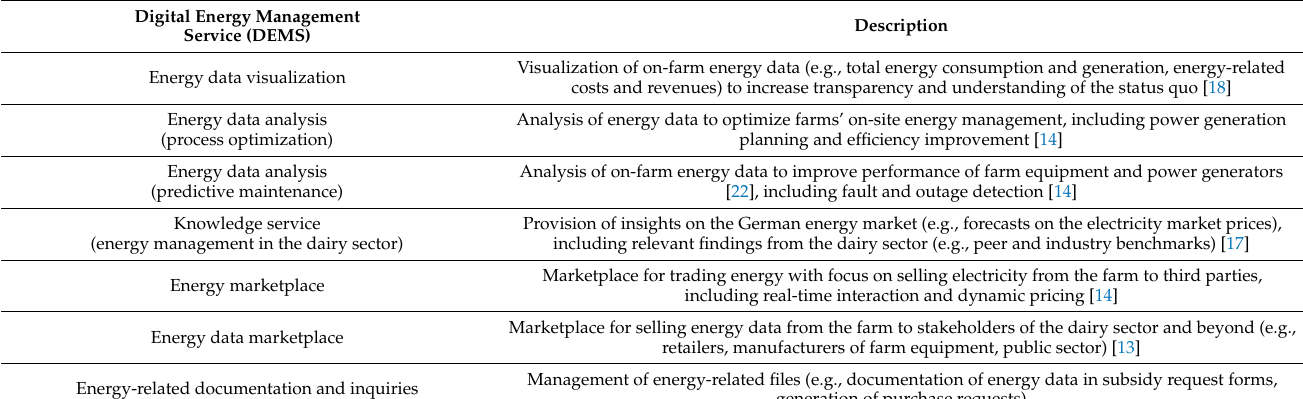
Table 1. Description of the seven DEMS from [20] in scope of this